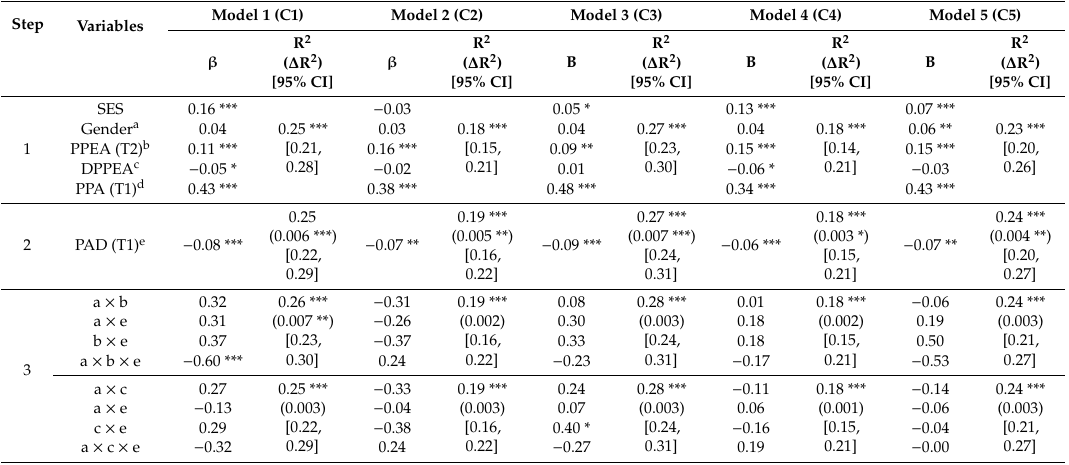
Table 6. Hierarchical multiple linear regression predicting perceived peer acceptance in Time 2.